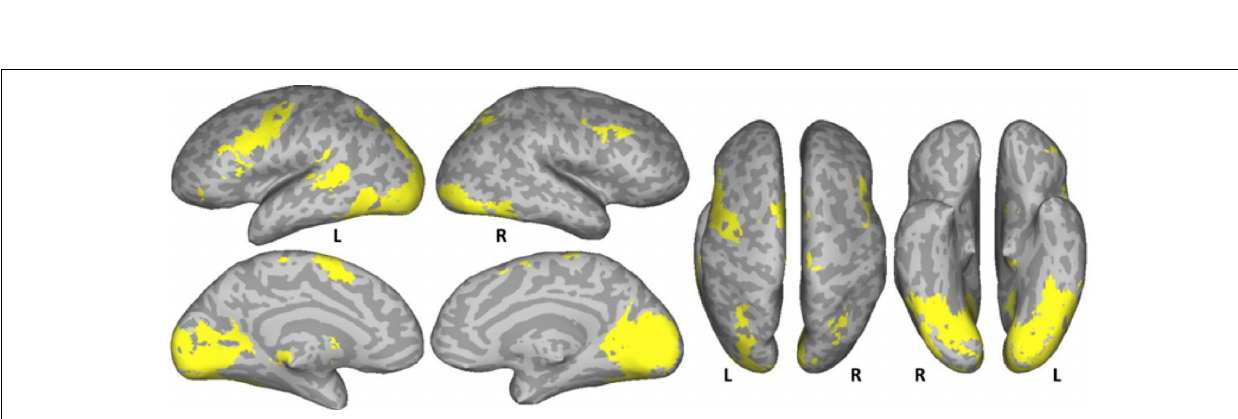
Frontiers in Human Neuroscience